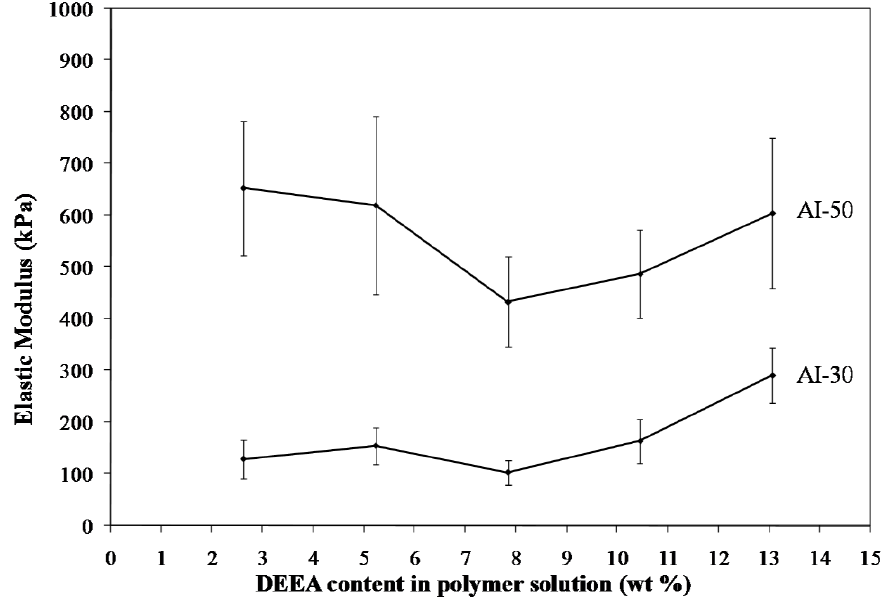
Figure 4. Compressive moduli of 5 wt.% Na + -MMT/2.5 wt.% AI-30 composites as a function of amine concentration.